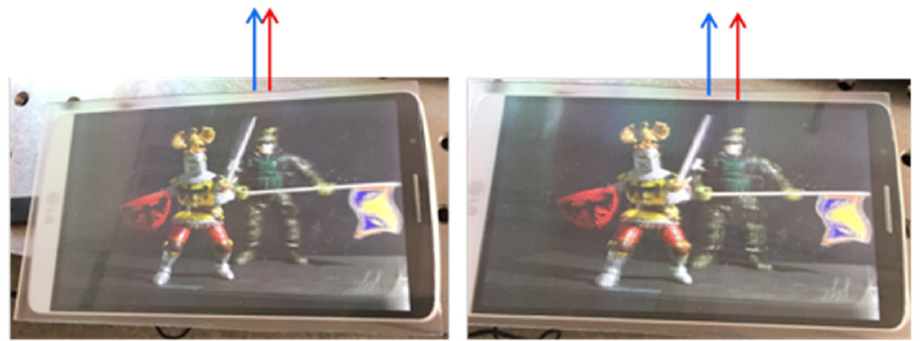
Figure 14. Three-dimensional images on the screen from different viewing directions. Relative displacements of different parts of fighters are shown by the arrows.